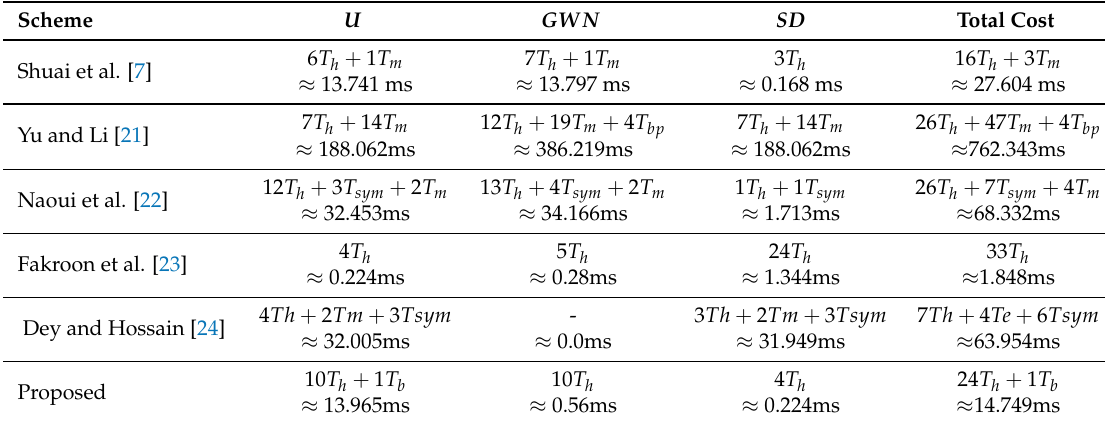
Table 2. Computation costs